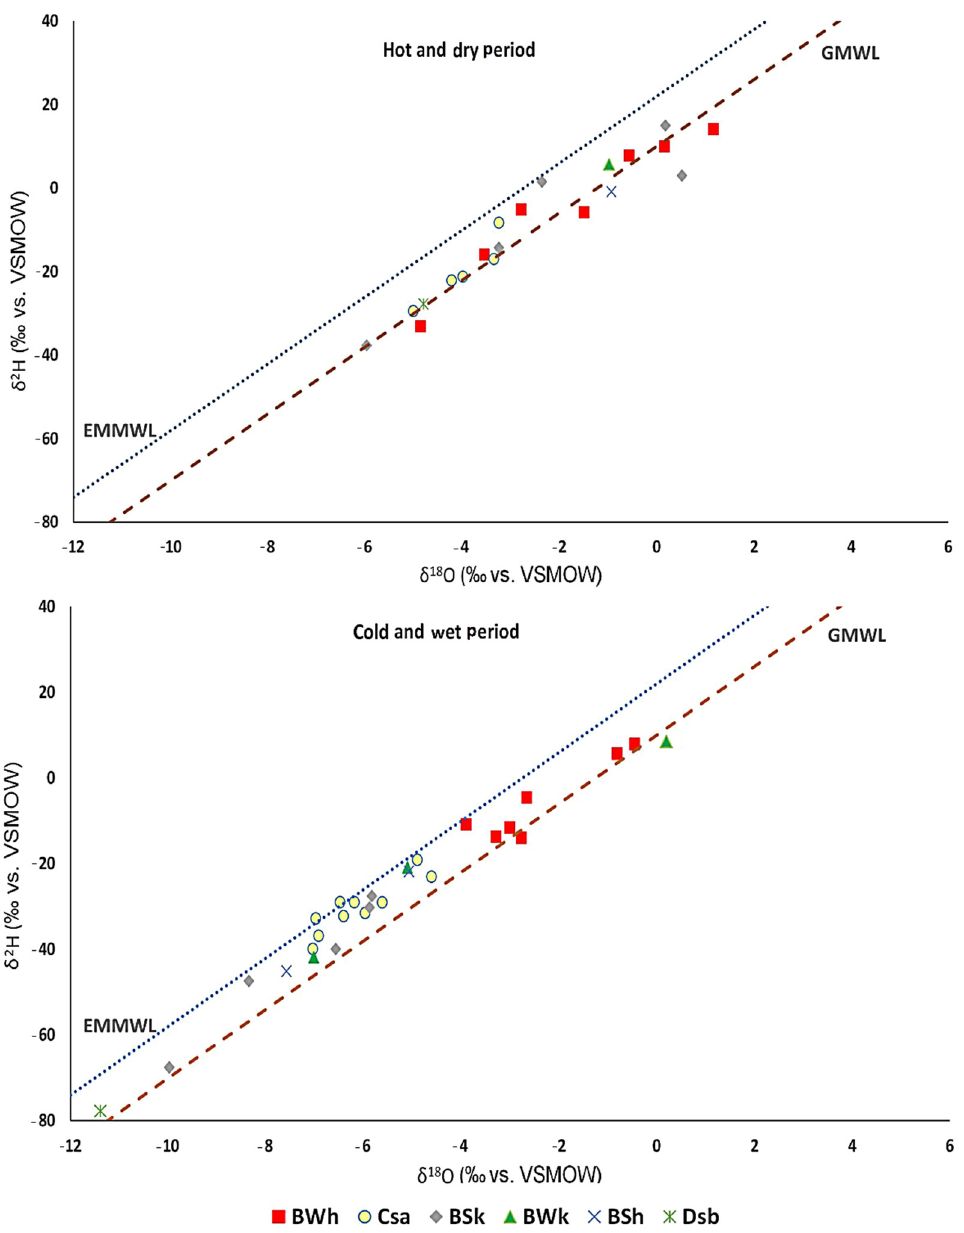
Figure 6. Plotting the stable isotopes in the studied stations on the EMMWL and the GMWL based on the Köppen climate zones.